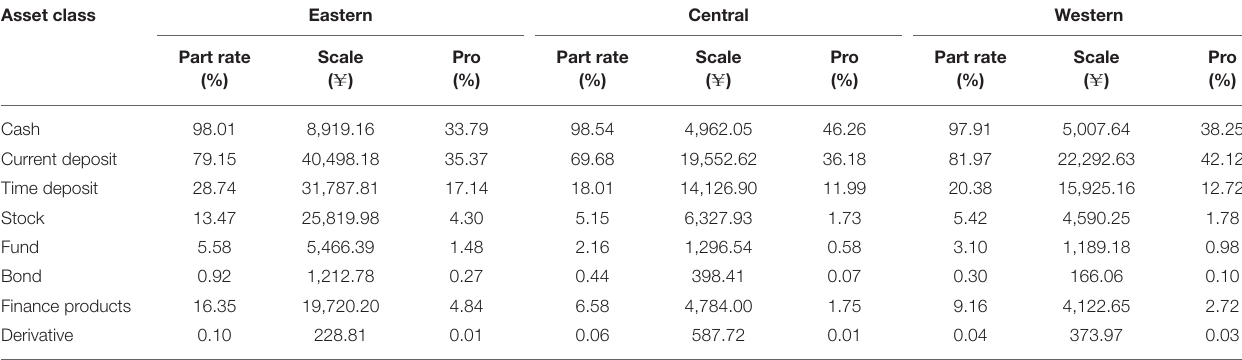
TABLE 2 | Household financial asset allocation (eastern, central, and western regions). Asset